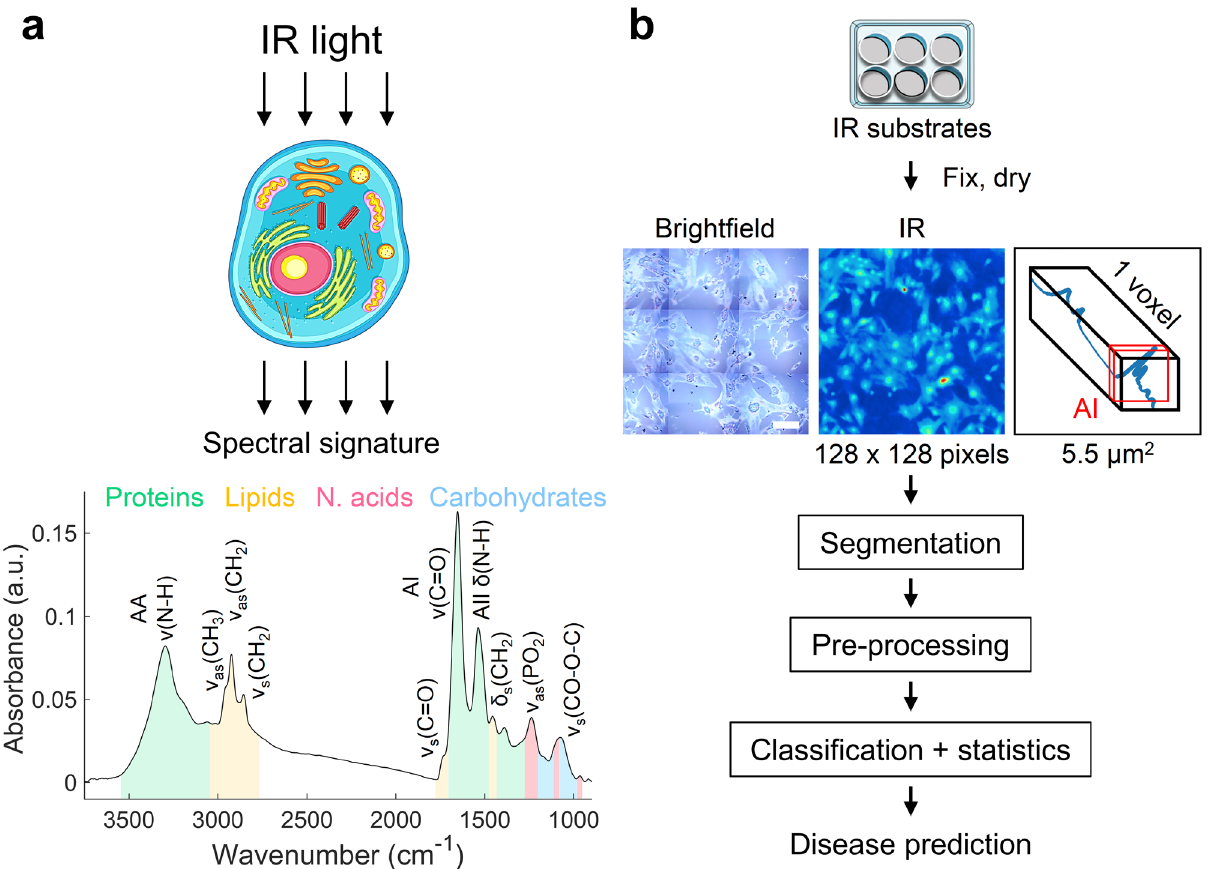
Figure 1. Concept of cell phenotyping by infrared spectroscopy. ( a ) Schematic of a representative infrared spectrum of astrocytes and the attribution of the prominent chemical features between 4000 and 900 cm −1 . AA/I/II: amide A/I/II, ν: stretching, δ: bending, as: asymmetric, s: symmetric vibrations. ( b ) Brief outline of the analysis pipeline for spectral phenotyping, as discussed in the text. After 7–10 days, cells are plated and cultured overnight onto IR compatible calcium fluoride (CaF 2 ) substrates, fixed and dried before the spectral analysis. A representative brightfield and corresponding IR image of astrocytes are displayed. IR images are reconstructed on the amide I band (AI) for optimal background/cell contrast. Each tile comprises 128 by 128 pixels (5.5 µm 2 ), each of which contains a FTIR spectrum (in blue), thus constituting hyperspectral images. The raw spectral images are carried through three processing steps to generate a cell signature. (Segmentation) The cells are segmented to extract from IR images the nucleus, cytoplasm, and whole cell raw spectra. (Pre-processing) Raw spectra are pre-processed to generate normalized second derivative spectra. (Classification and